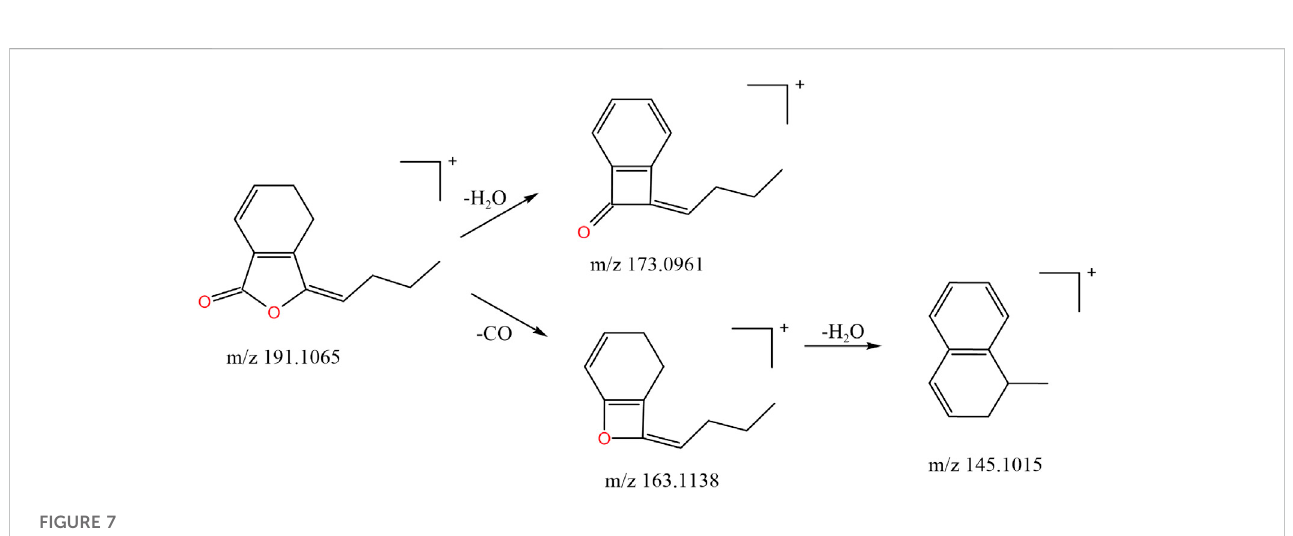
FIGURE 7 The FP of E-ligustilide in positive ion